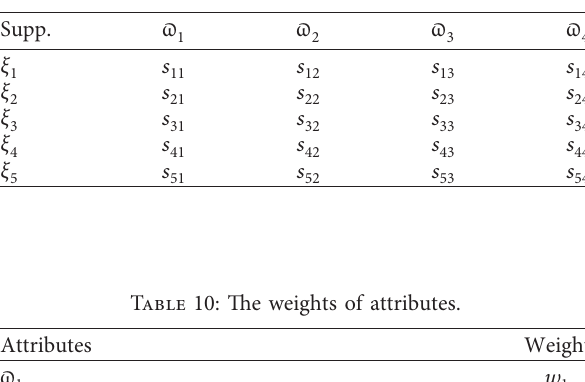
Table 9: Aggregated picture fuzzy decision